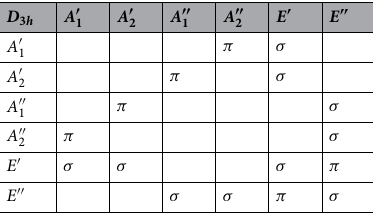
Table 5. Electric Dipole selection rules in D 3 h symmetry. σ represents in plane transitions while π represents out of plane transitions.